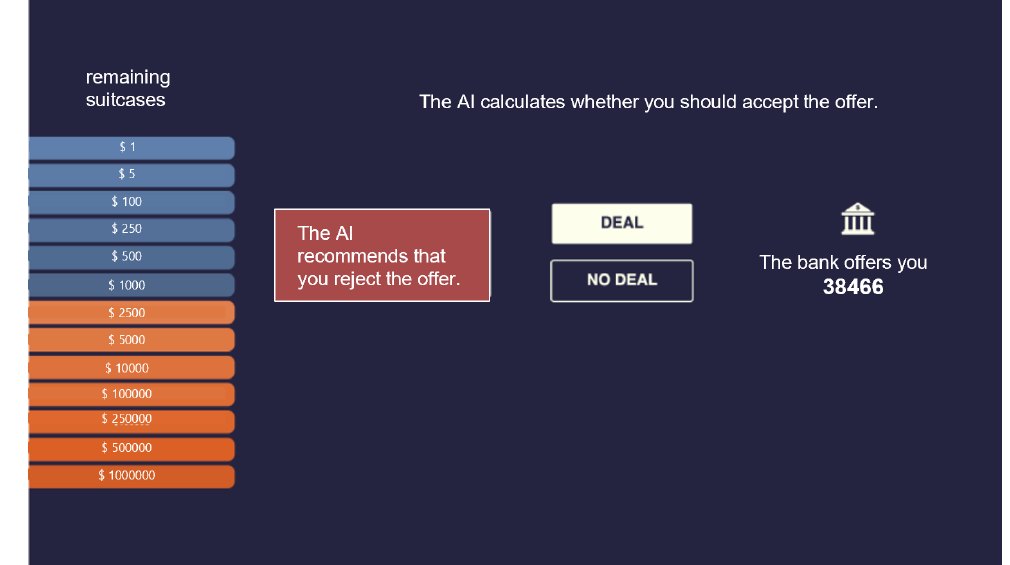
Figure 5. Example of a display in the ’no’ explanation